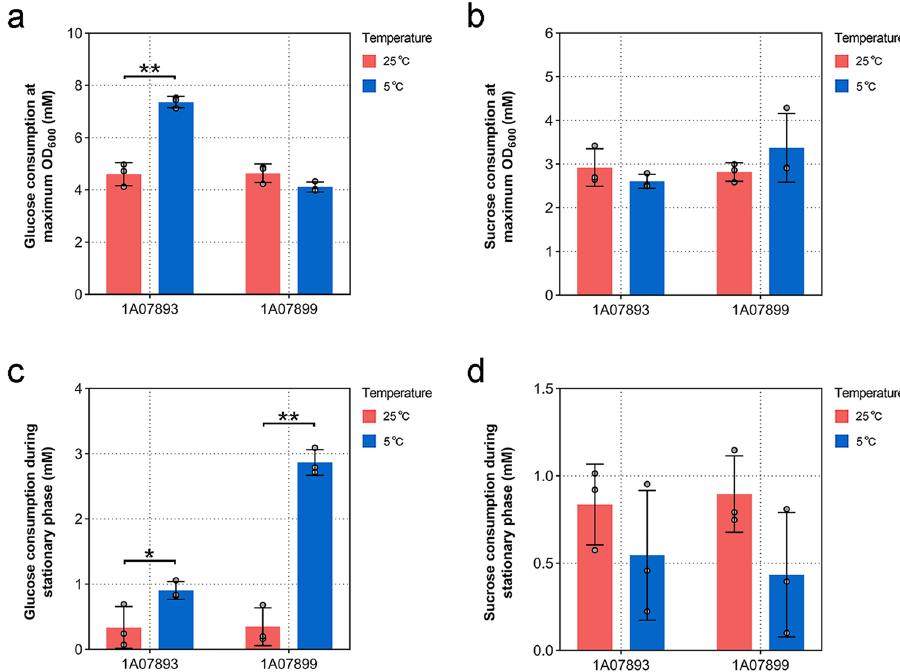
Fig. 6 Competitive carbon consumption experiments comparing the utilization of glucose and sucrose by L. salsilacus . a Glucose consumed by L. salsilacus grown on the de fi ned substrate mixture were measured at maximum OD 600 at 5 °C and 25 °C. b Sucrose consumed by L. salsilacus grown on the de fi ned substrate mixture were measured at maximum OD 600 at 5 and 25 °C. c Glucose consumed by L. salsilacus incubated in the de fi ned substrate mixture were measured during the same time in stationary phase. d Sucrose consumed by L. salsilacus incubated in the de fi ned substrate mixture were measured during the same time in stationary phase. The experiments were performed in triplicate and the average values are given. Error bars represent standard deviations, and signi fi cant differences are indicated by asterisks (* p < 0.05; ** p < (Fig. 6c), whereas no signi fi cant changes in sucrose consumption were observed between 5 and 25 °C (Fig. 6d). A similar utilizing pattern of glucose and sucrose consumed by 1A07899 at different temperatures also have been identi fi ed in the stationary growth stage.